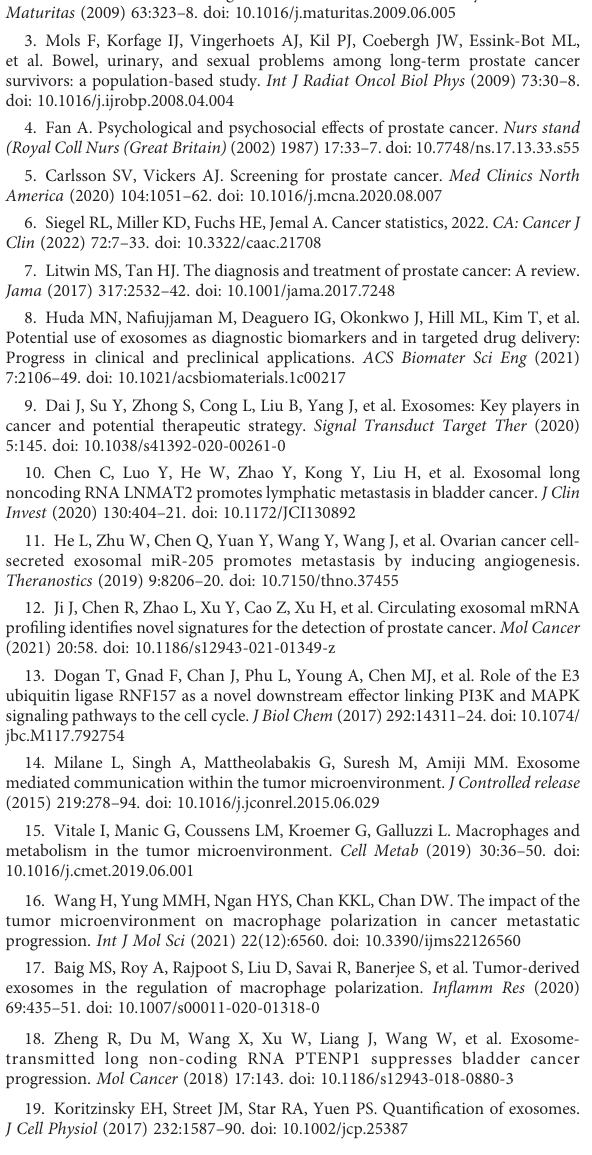
SUPPLEMENTARY FIGURE 1 M2 polarization of macrophages was promoted after co-culturing with PCa cells. (A) Light microscope was used to observe the change in cell morphology after PMA treatment and RT-qPCR evaluated the expression level of M0 maker (CD68). (B) Flow cytometry detected M2 polarization of macrophages before and after co-culturing with PC-3 cells that were treated with or without GW4869. (C) ARG1 and IL-10 expressions were analyzed via RT-qPCR in different groups. ** P < 0.01.